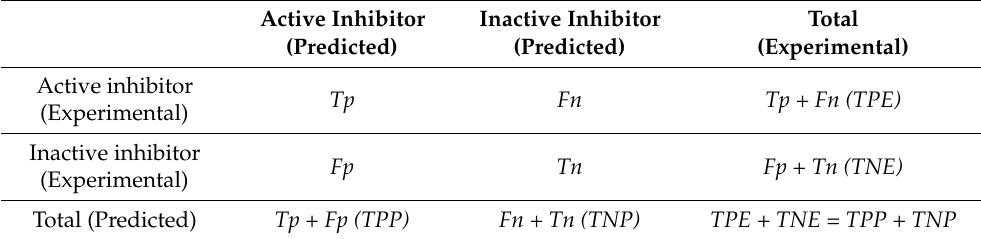
Table 8. Confusion matrix for the calculation of statistical parameters 1